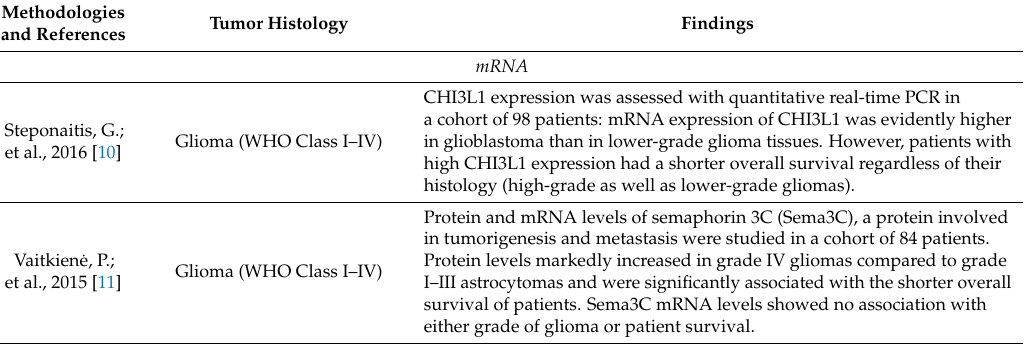
Table 2. Nanotech and Biomedical Engineering advances in identification of mRNA biomarkers in neuro-oncology.